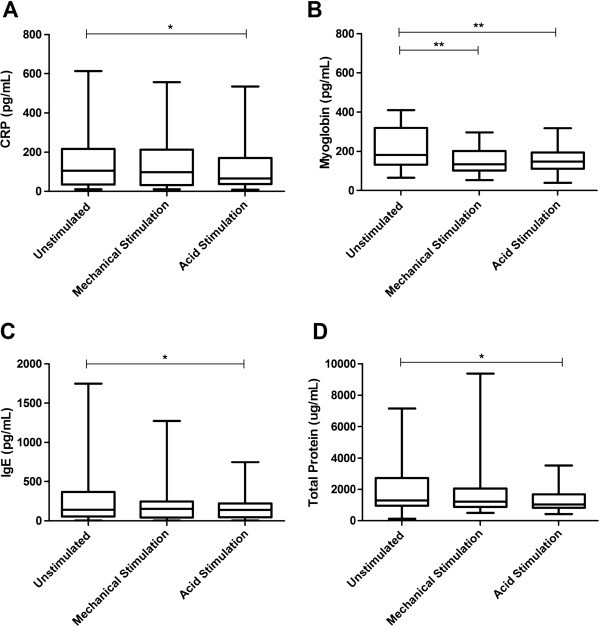
Concentration of (A) CRP, (B) Myoglobin, (C) IgE and (D) Total Protein in the resting drool, mechanically stimulated drool and acid stimulated drool samples. Minimum and maximum data values are indicated by bottom- and top-most points of box plot. Lower quartile, median and upper quartile values are indicated by first, second and third horizontal lines of the box in the box plot. Significance is shown as *p <0.05,**p <0.01, ***p <0.001.